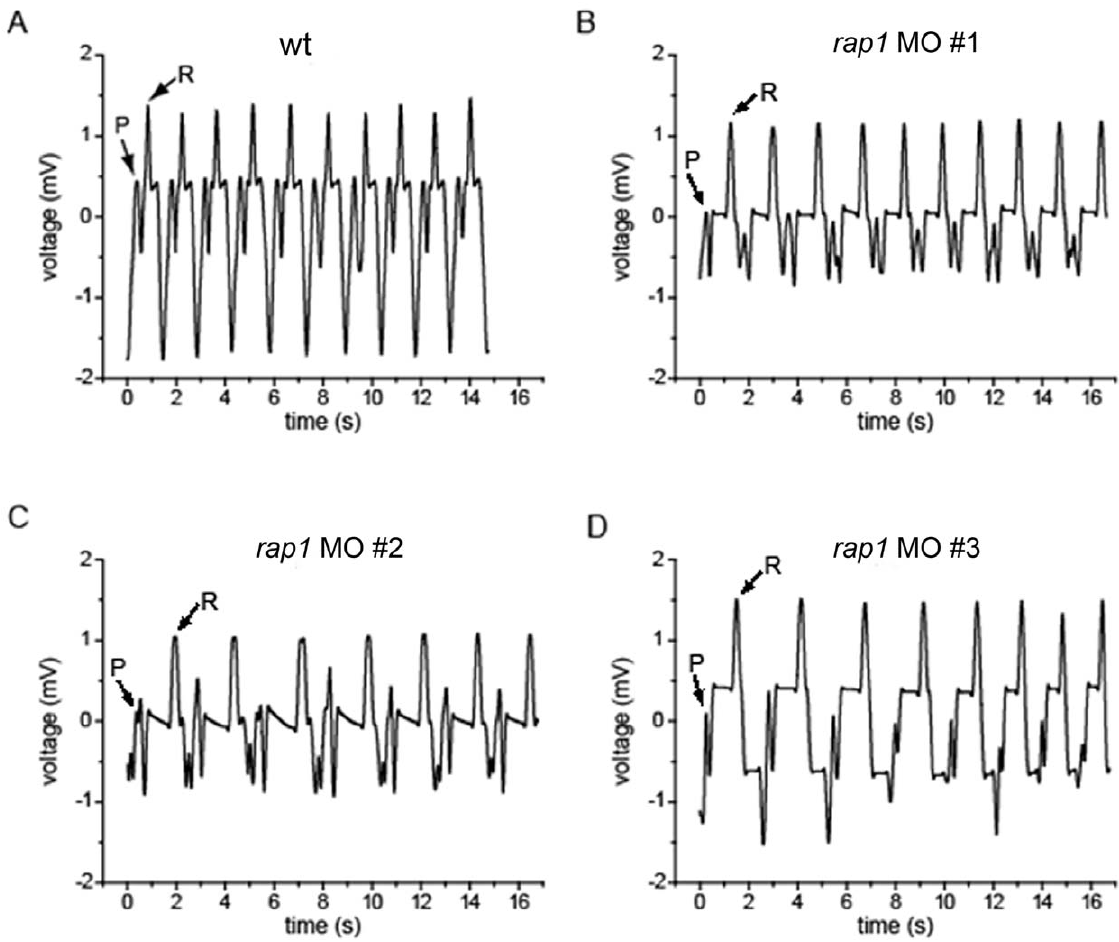
Figure 4. Rap1 knock-down zebrafish have prolonged P-R intervals, resembling the first-degree atrio-ventricular block. Zebrafish heart electrocardiography (ECG) was measured in wild type larvae (A), and rap1 MO hearts at 3 dpf (B to D).